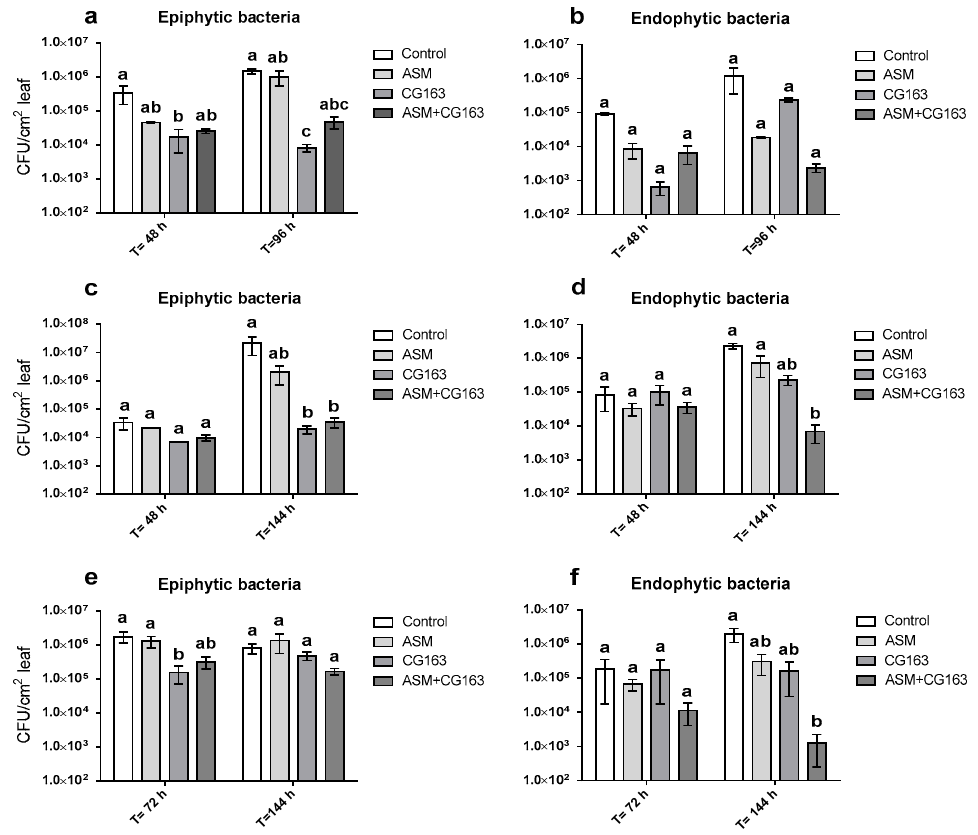
Figure 5. Three separate experiments, with time-points of 48 and 96 h (Experiment 1: ( a , b )), 48 and 144 h (Experiment 2: ( c , d )) and 72 and 144 h (Experiment 3: e , f ), measuring average epiphytic ( a , c , e ) and endophytic populations ( b , d , f ) of Pseudomonas syringae pv. actinidiae (CFU / cm 2 of leaf) in Actinidia chinensis var. deliciosa ‘Hayward’ potted plants. Plants were treated with acibenzolar-S-methyl (ASM), Aureobasidium pullulans isolate CG163 (CG163), combination of ASM and CG163 (ASM + CG163) or untreated (control) 7 and 1 day before inoculation with Pseudomonas syringae pv. actinidiae . Values are means ± SE of two biological replicates for Experiments 1 + 2 and six biological replicates for Experiment 3. Each biological replicate consisted of an average of one inoculation spot on three (Experiment 1 + 2) or two (Experiment 3) di ff erent leaves on the same plant. Bacterial populations just after inoculation consisted of two (Experiments 1 + 2) or six (Experiment 3) untreated biological replicates for all treatments, with each biological replicate consisting of an average of one inoculation spot on three (Experiments 1 + 2) or two (Experiment 3) di ff erent leaves on the same plant. Average epiphytic and endophytic bacterial populations were notated with di ff erent letters, signifying di ff erences according to average back-transformed bacterial populations of a generalized linear mixed model (GLMM) with a 95% confidence interval.